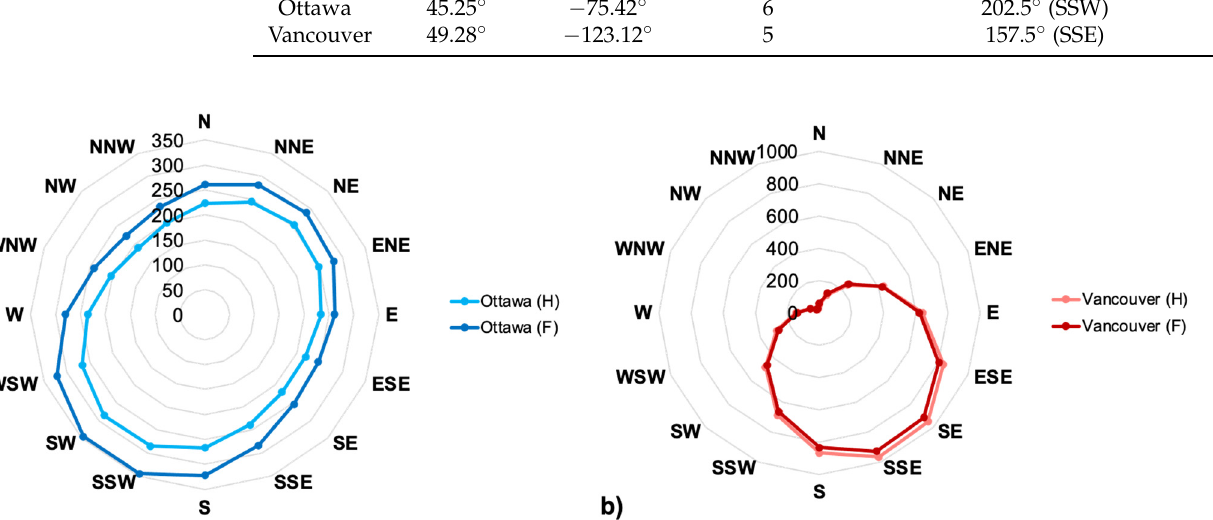
Figure 3. Annual average driven-rain index for ( a ) Ottawa and ( b ) Vancouver over historical and future time periods.